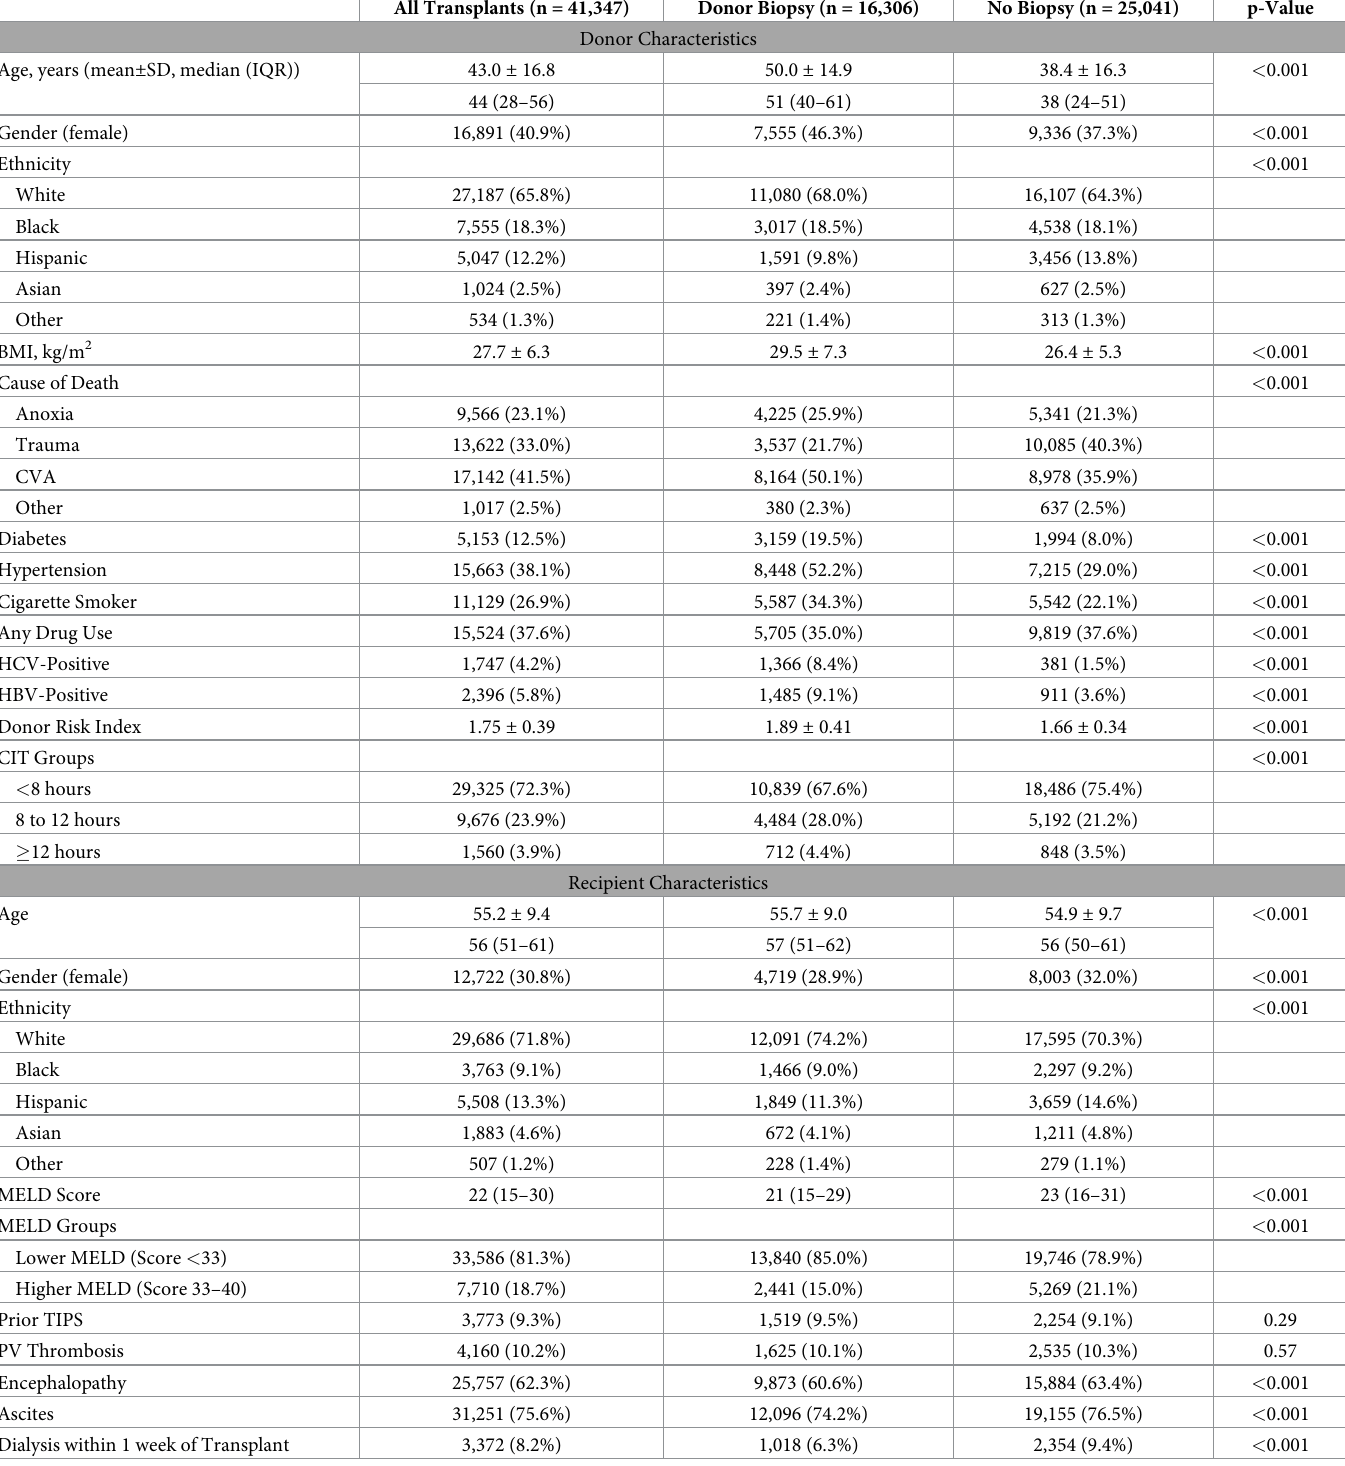
Table 1. Selected donor and recipient characteristics for transplants with and without donor liver